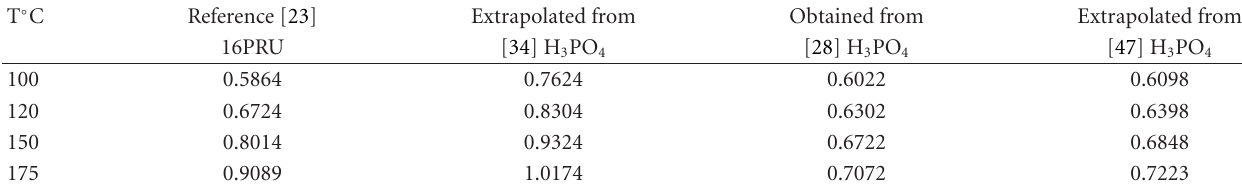
Table 1: Variation in values of transfer coe ffi cient with temperature from references [23, 28, 34, 47]. T ◦